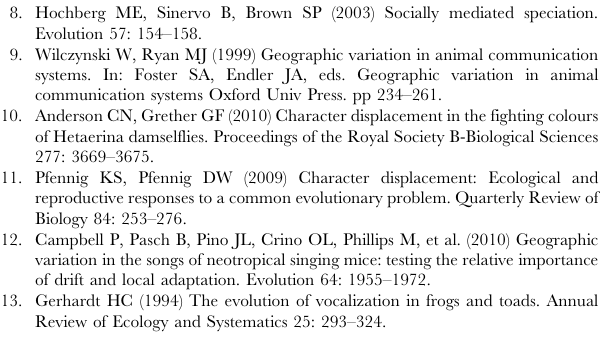
Figure S1 Drawing used to score the variation in P. dominulus facial patterns within the Ukrainian popula- tions. (TIF) Movie S1 Video containing the bitmaps used to create Fig. 3, as well as pictures of P. dominulus from Italy, Hungary, Michigan, and New York. Wasps with entirely yellow faces were typically not photographed.